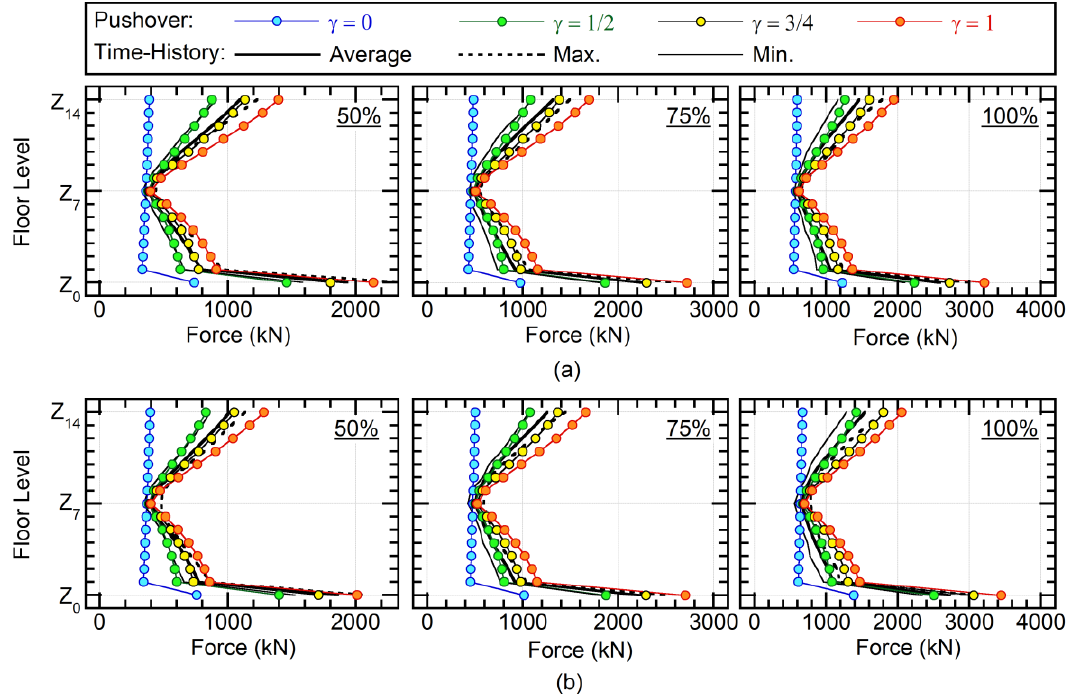
Figure 20. Comparison of the peak restoring force for Model-14: ( a ) Art-S series and ( b ) Art-L series.